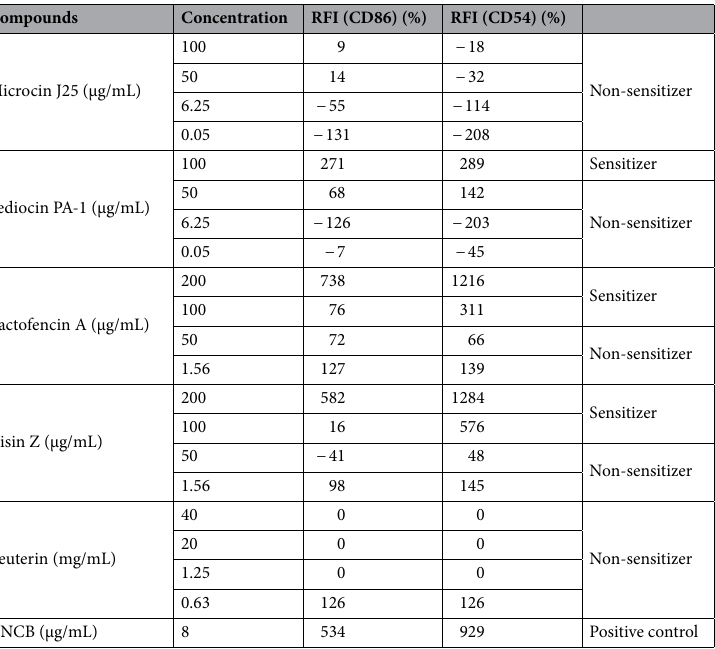
Table 1. Prediction of skin sensitization potency of MccJ25, pediocin PA-1, bactofencin A, nisin and